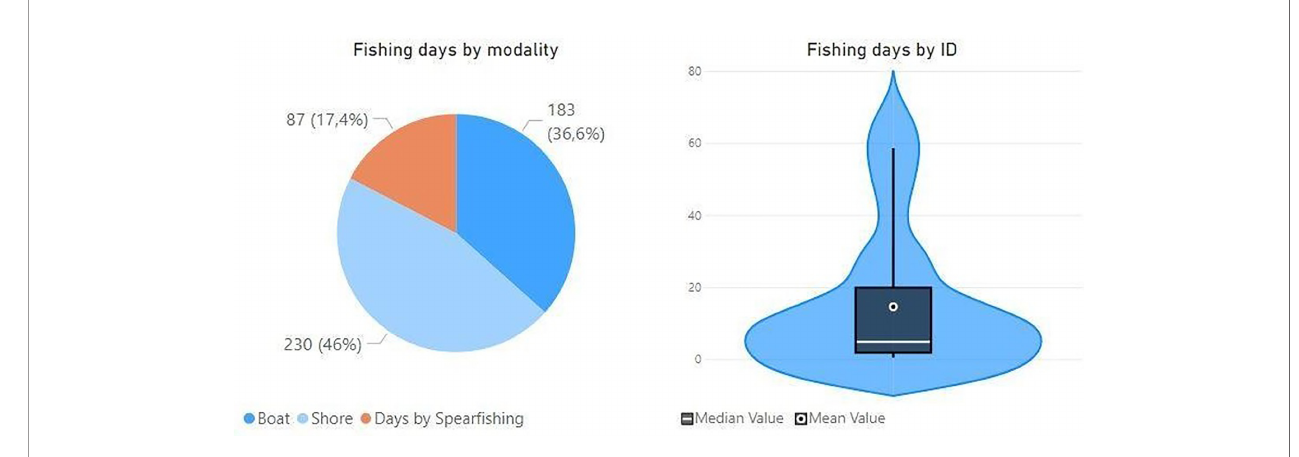
FIGURE 2 | Number of fi shing days by modality (left) and mean yearly fi shing days (right)